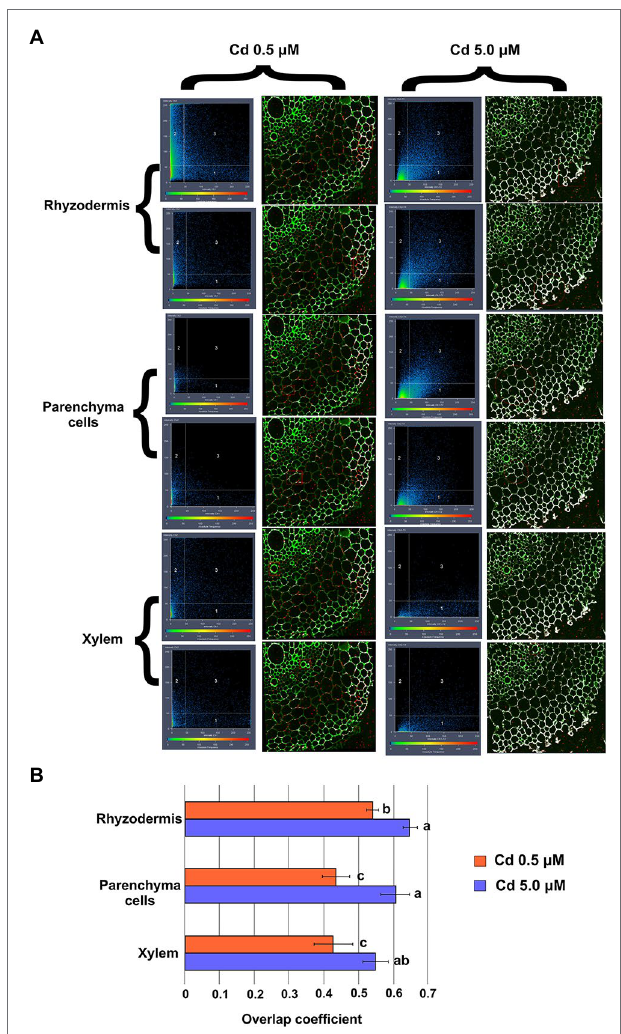
FIGURE 9 | Colocalization of Cd (labeled with LG dye) and nicotianamine (labeled with anti_NA and fluorescent secondary antibodies) in root cross- sections (15 days from sprouting and from the start of Cd treatments). Panel (A) Representative “crosshair” scatterplots of green (LG) and red (Anti_NA) pixels intensity and colocalization in rhizodermis, parenchyma cells and xylem. Panel (B) Evaluation of green (LG) and red (Anti_NA) pixels colocalization by the Mander’s overlap coefficient. Data were analyzed by ANOVA followed by Tukey’s post hoc test. Different letters correspond to statistically different